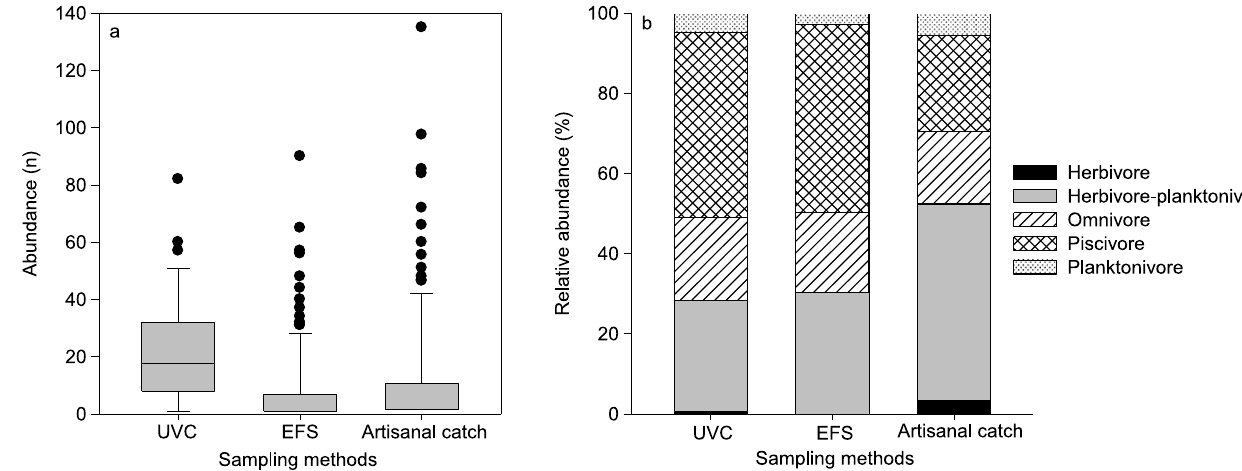
Fig. 4. (a) Number of fi shes per sampling unit in each of the sampling methods used, (b) Trophic classi fi cation of fi shes associated with FADs shown as % of fi sh abundance. The box-plot represent the quartiles around the median (line inside the box), the dots outside the box represent the outliers.